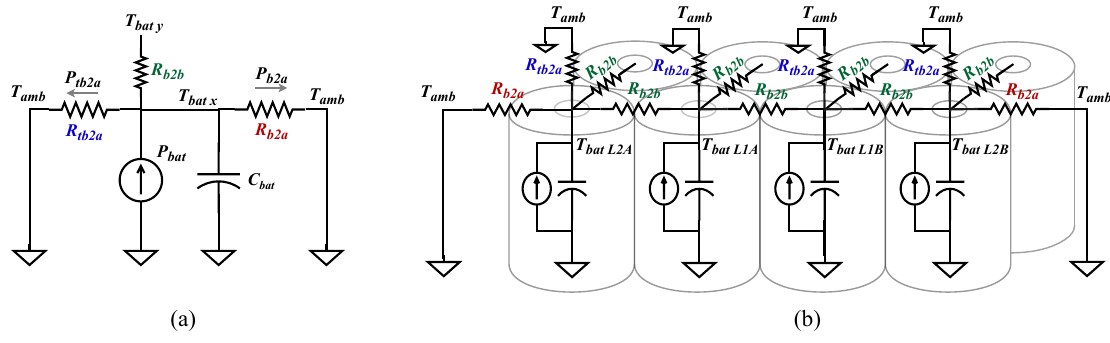
Figure 8. ( a ) Lumped RC-thermal circuit model for a unit cell. ( b ) Thermal RC network model for a slice in the battery